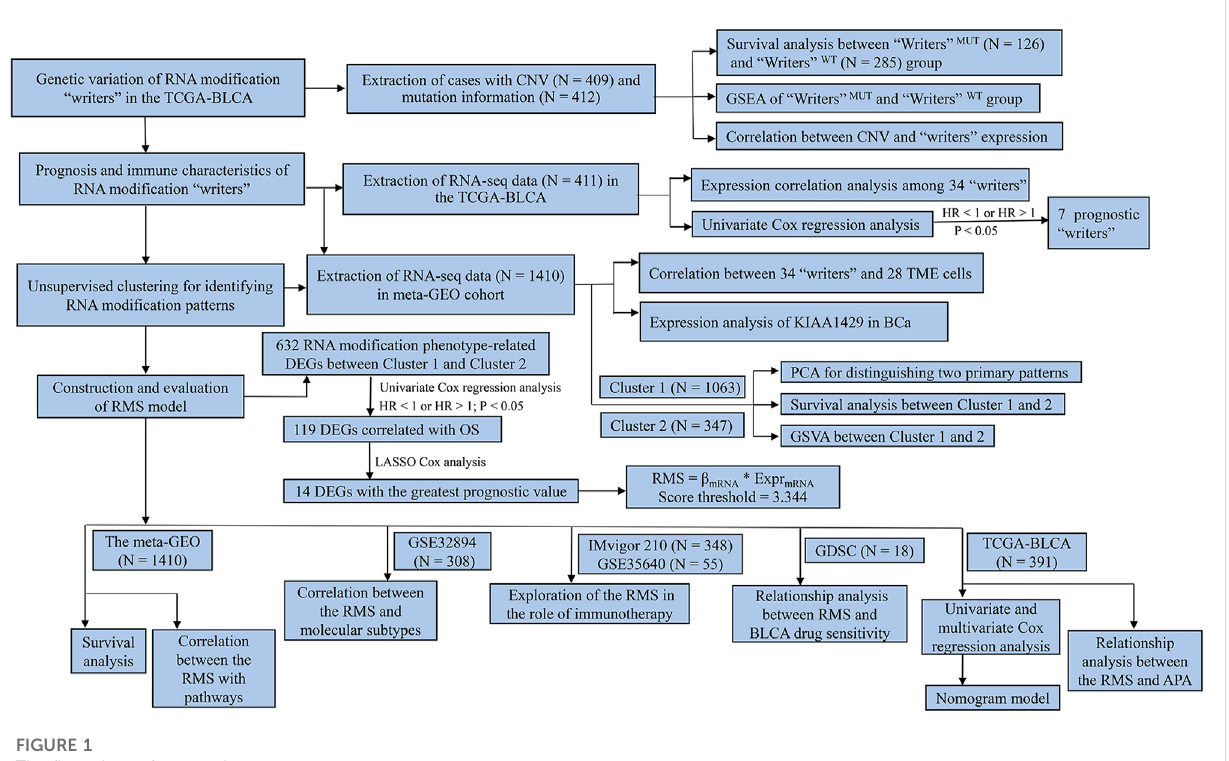
FIGURE 1 The fl ow chart of our